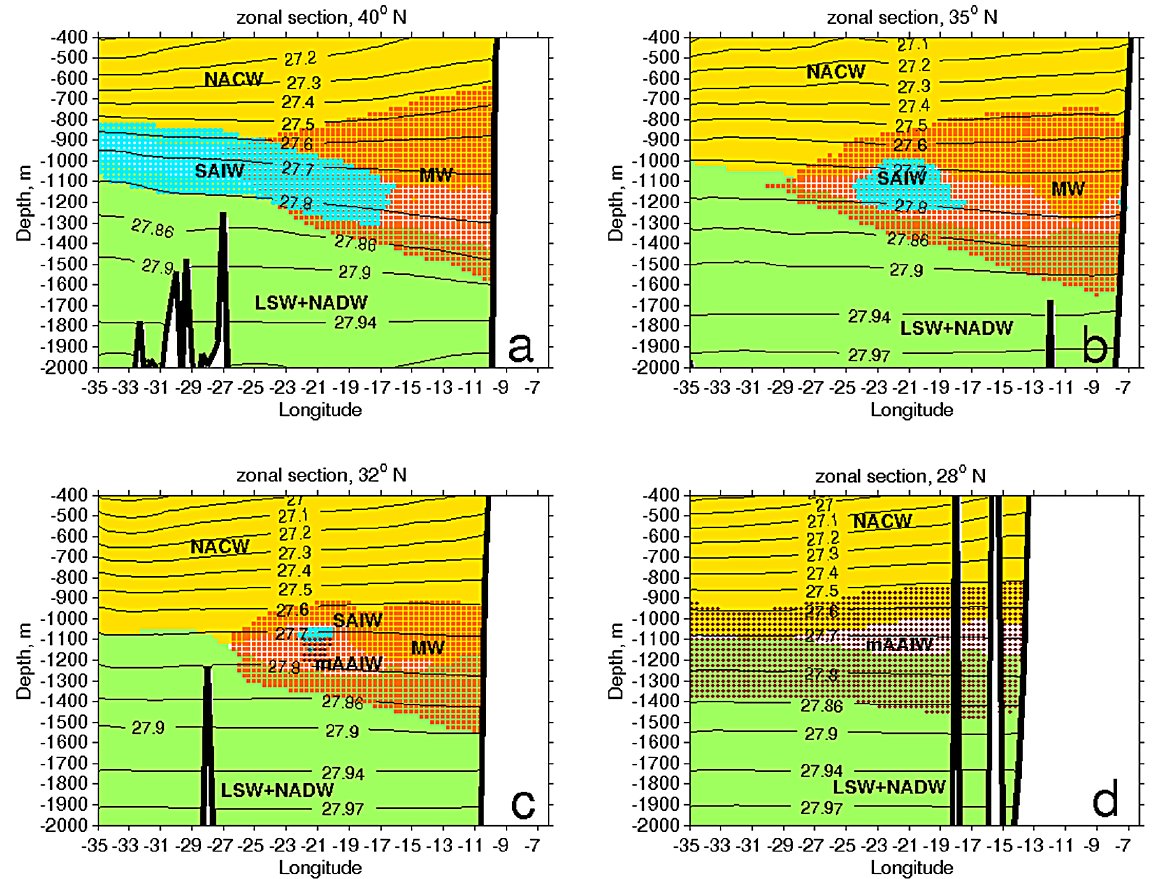
Figure 10. Distribution of water masses, the contribution of which exceeds 25%, along zonal sections: (a) 40 ◦ N, (b) 35 ◦ N, (c) 32 ◦ N, (d) 28 ◦ N. Yellow is NACW, green – LSW and NADW, orange – MW, cyan – SAIW, brown – mAAIW. Note, that there is an overlap of different water masses at some areas, since in a point more than one water mass may have contribution over